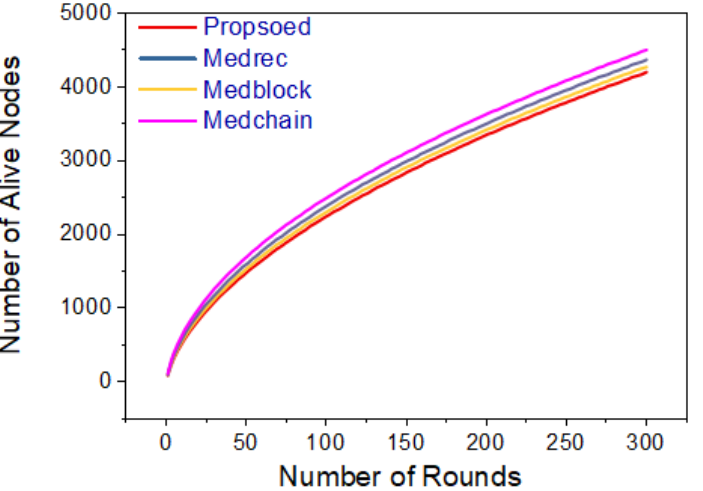
Figure 23. Simulation results based on a comparison of the proposed model with the benchmark flexible policies for cross-domain models